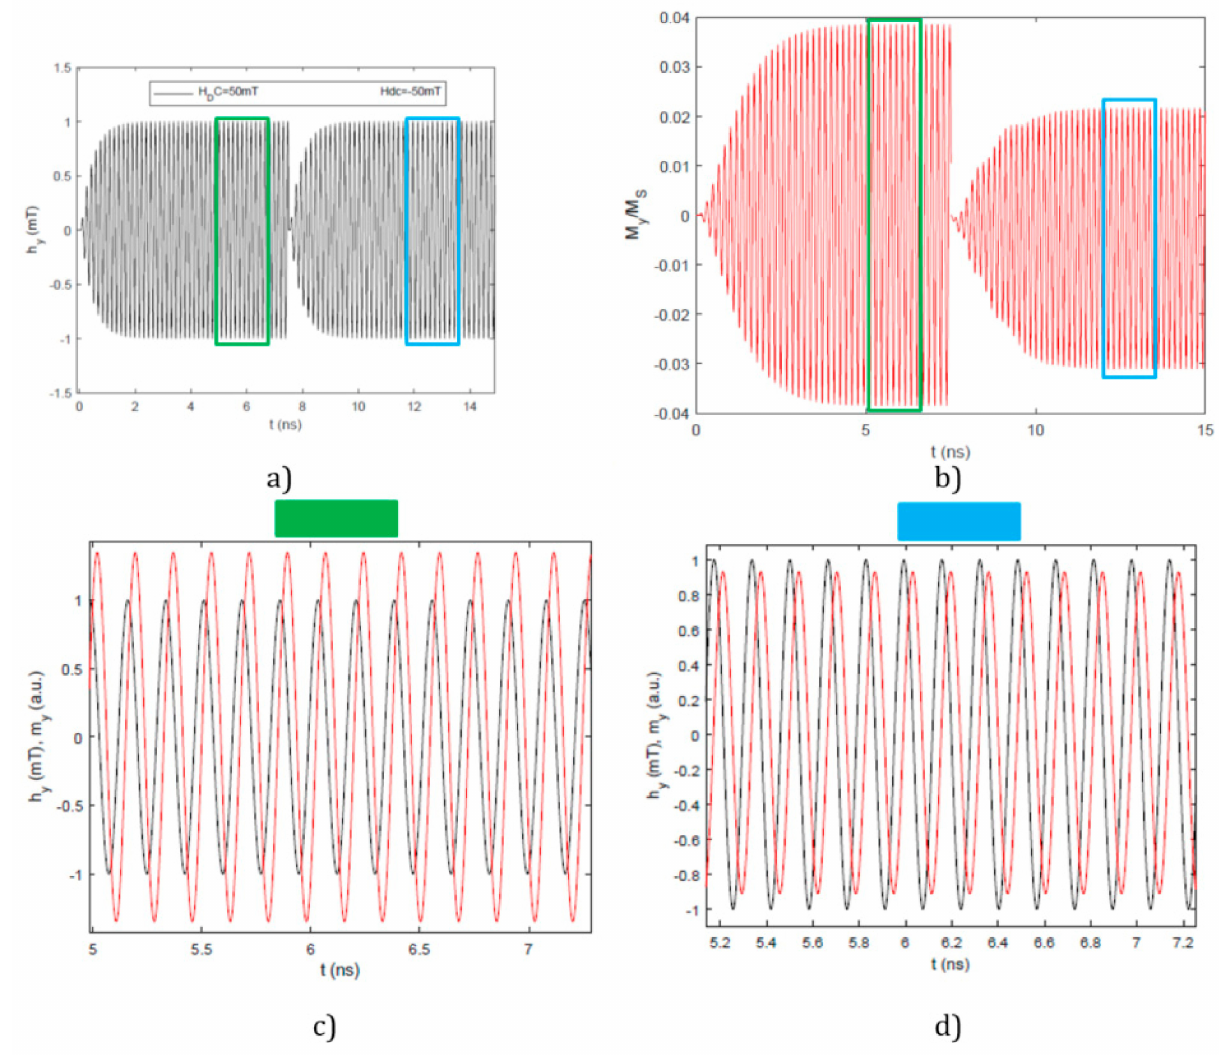
Figure 7. NdCo x -(10nm-Al)-Py: ( a ) sinusoidal h ACx temporal evolution for: descending-H DC (0–7.5 ns)/ascending-H DC (7.5 ns–15 ns); ( b ) corresponding average m y (t) in Permalloy, joint temporal stationary variation of average m y in Permalloy and h AC ; ( c ) descending-H DC (green); ( d ) ascending-H DC